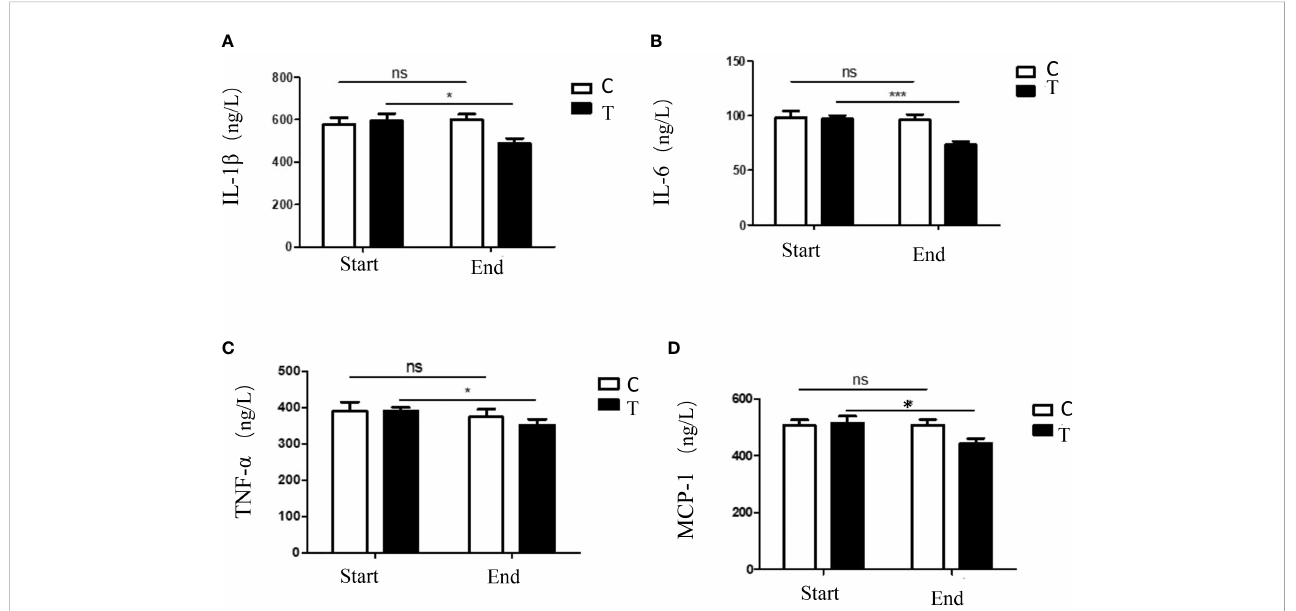
FIGURE 2 The serum levels of in fl ammatory chemokines in participants with T2DM altered by the high- fi ber diet intake. Expressions of serum levels of IL-1 b (A) , IL- 6 (B) , TNF- a (C) and MCP-1 (D) in participants during the intervention were shown. The symbols * indicates p< 0.05, symbols*** indicates p< 0.001, ns indicates no signi fi cant difference.